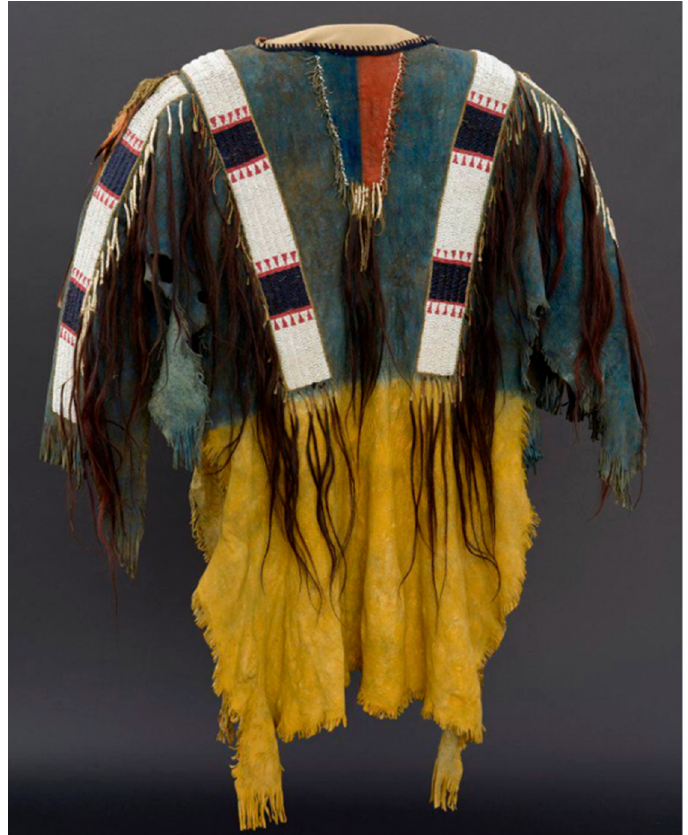
Figure 4. Oglála Lak ȟ óta Shirt, c. 1868, tanned hide, wood cloth, pigments, glass beads, dyed porcupine quills, golden eagle feathers, northern flicker feathers, human hair, sinew, 97.79 cm × 48.26 cm. Plains Indian Museum, Buffalo Bill Center of the West, Cody, WY, Paul Dyck Collection, NA 202.1052. Used by permission of the Buffalo Bill Center of the West.